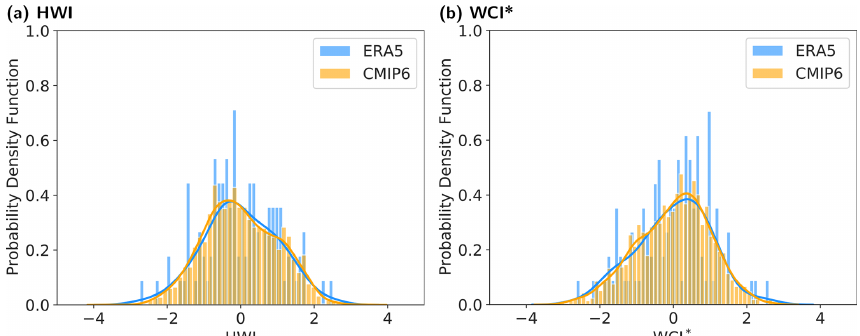
Figure 3. Probability distribution of (a) HWI and (b) WCI ∗ calculated from CMIP6 (orange) and ERA5 (azure) for present-day East Asia winter (DJF